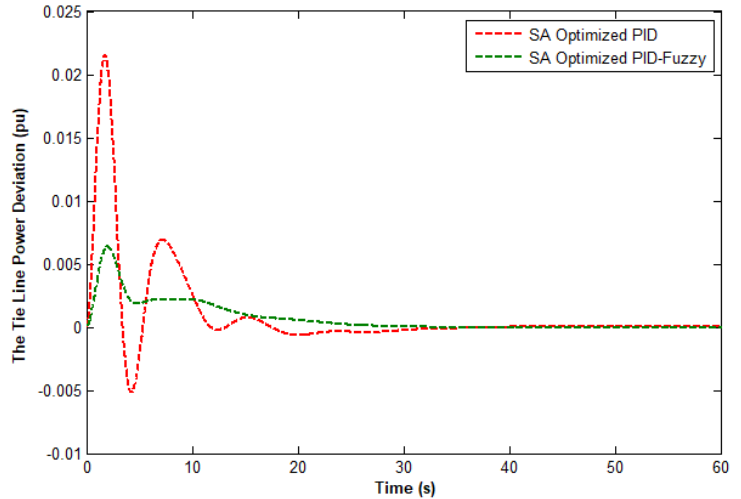
Figure 11. Frequency deviations in area 2 for the second case.